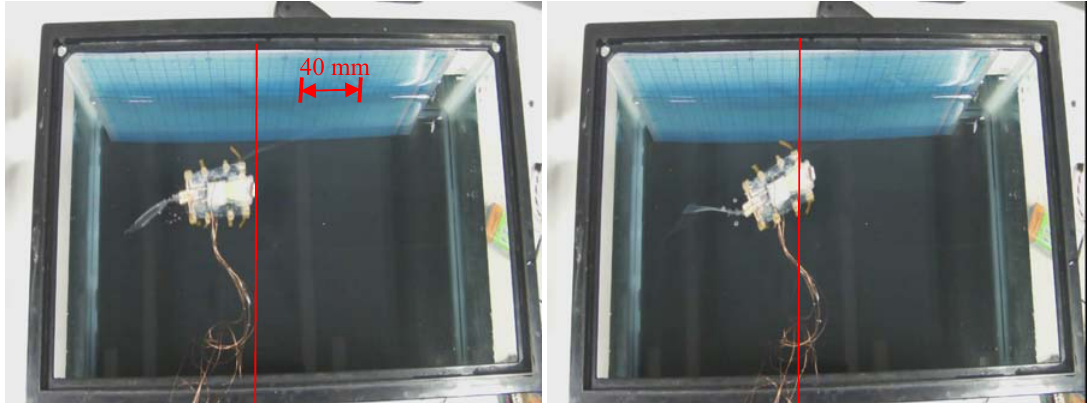
Figure 29. Swimming